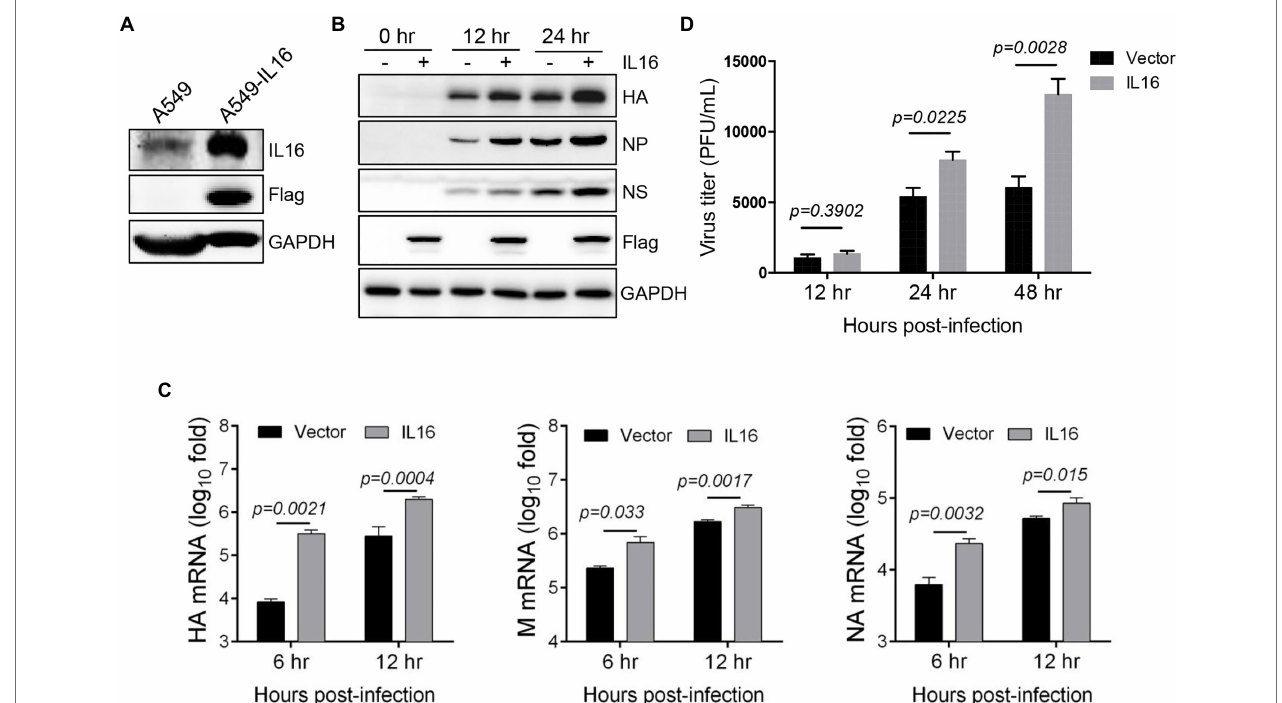
FIGURE 2 | IL16 overexpression promotes IAV replication. (A) Detection of endogenous IL16 expression by immunoblot analyses. A549 cells transfected with IL16-Flag expressing plasmids was used as a positive control. GAPDH was used as a loading control. A549 cells were transfected with vector or IL16-Flag-expressing plasmid, followed by infection with PR8 virus (MOI = 0.1) for indicated time points. (B) The infected cells were harvested at 0, 12, and 24 h post-infection and subjected to immunoblot analyses with the indicated antibodies. GAPDH was used as a loading control. (C) The infected cells were harvested at 6 and 12 h post-infection. The relative RNA levels of viral hemagglutinin (HA), M, and neuraminidase (NA) genes were measured by quantitative RT-PCR (qRT-PCR). Histograms represent mean ± SD of triplicate samples (two experiments). A value of p < 0.05 was considered significant. (D) The supernatant was collected from the infected cells at 12, 24, and 48 h post-infection, and virus titer was measured by plaque assays. Histograms represent mean ± SD of triplicate samples (two experiments). A value of p < 0.05 was considered